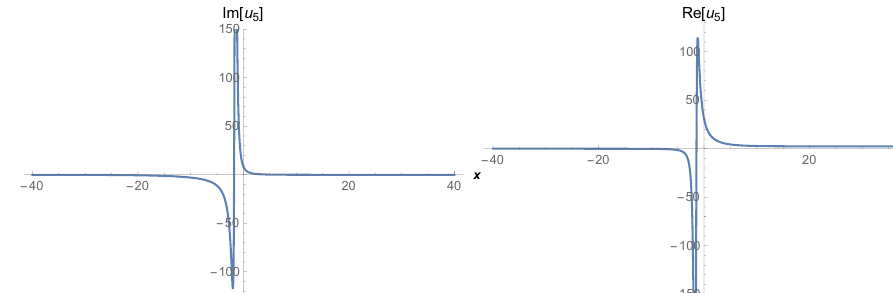
Figure 11. The 2D figures of Equation